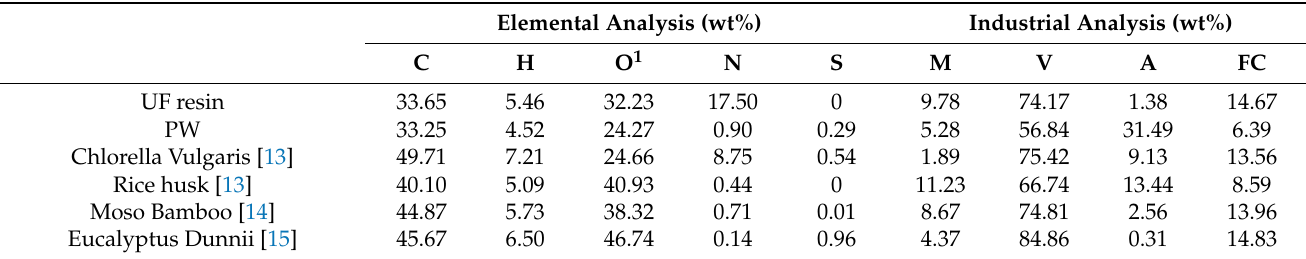
Table 1. Elemental analysis and industrial analysis of the samples. Elemental Analysis